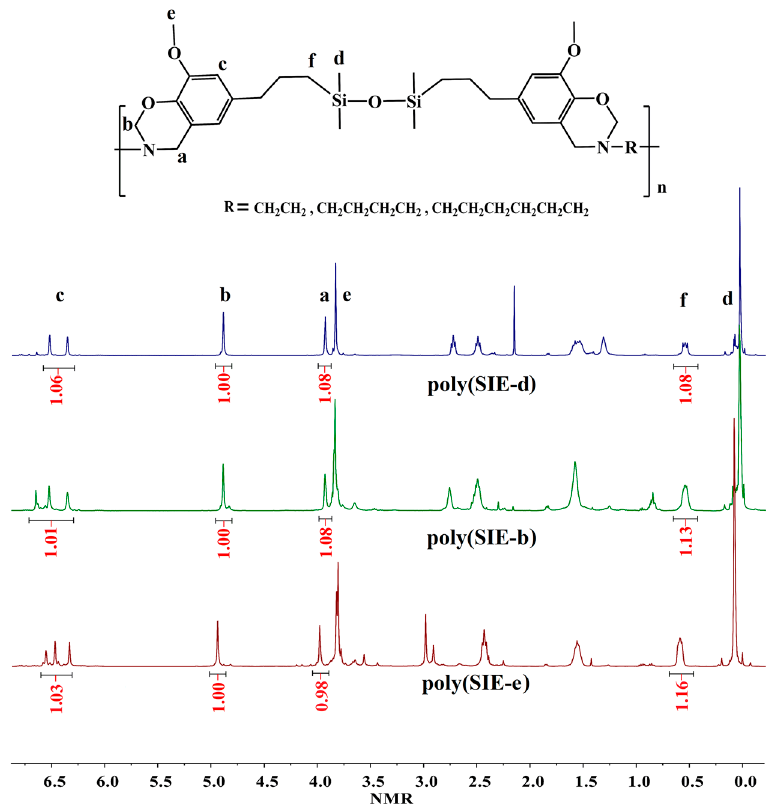
Figure 4. NMR spectra of different benzoxazine oligomers .